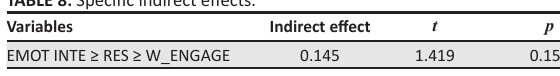
TABLE 8 : Specific indirect effects.